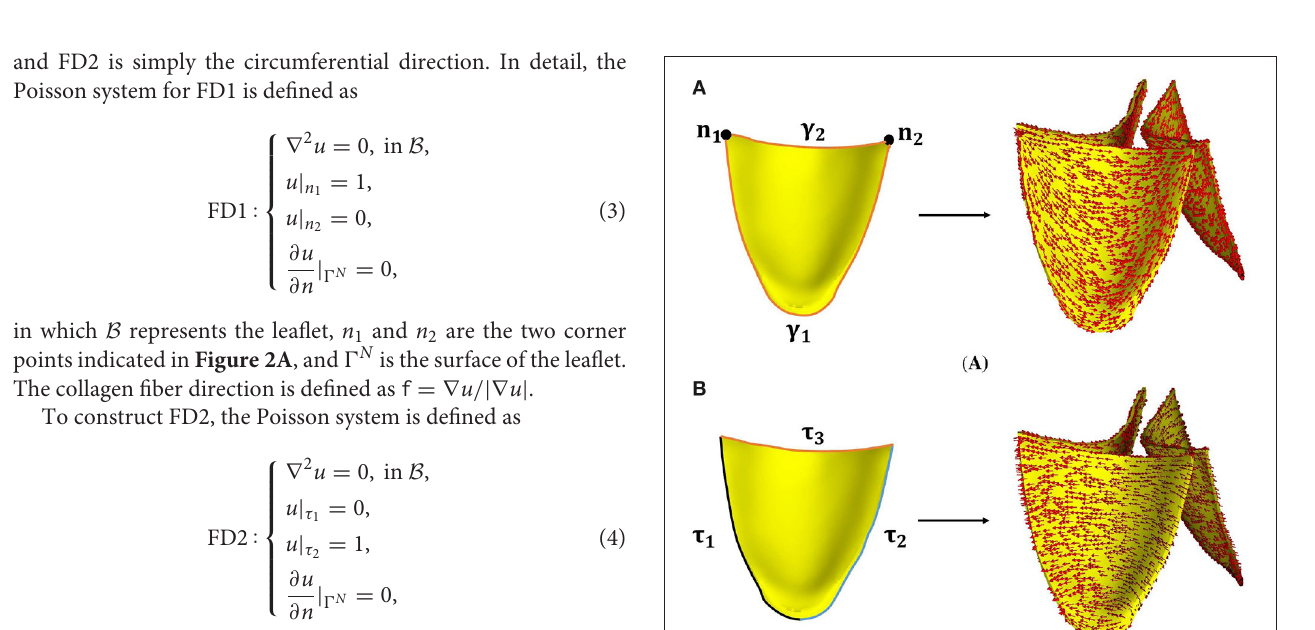
FIGURE 1 | The geometric model of the aortic valve (AV).